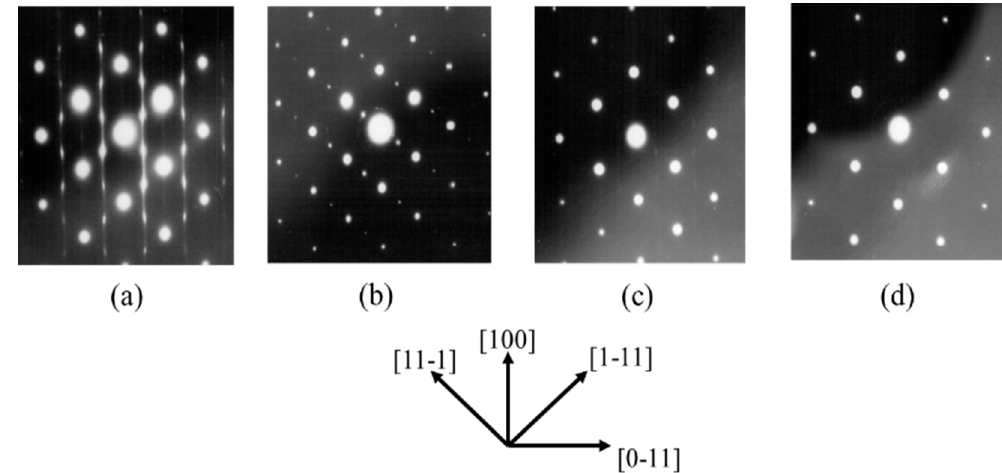
Figure 1. Transmission electron diffraction (TED) patterns of GaInP epitaxial layers for: ( a ) Ex144; ( b ) Ex145-B; ( c ) Ex145-A; and ( d ) Ex148.